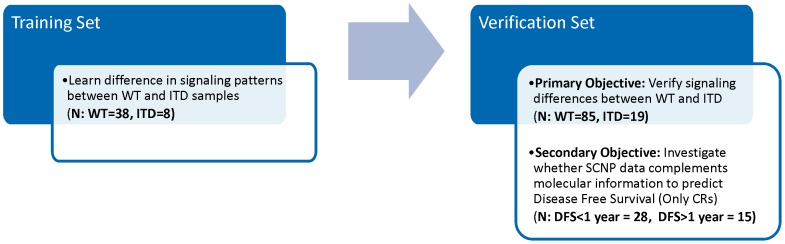
Study Design Diagram.Influence of FLT3 ITD mutation status on functional signaling was studied in two independent data sets; observations made in the first set (training, N = 46) were verified in the second set (Verification, N = 104).